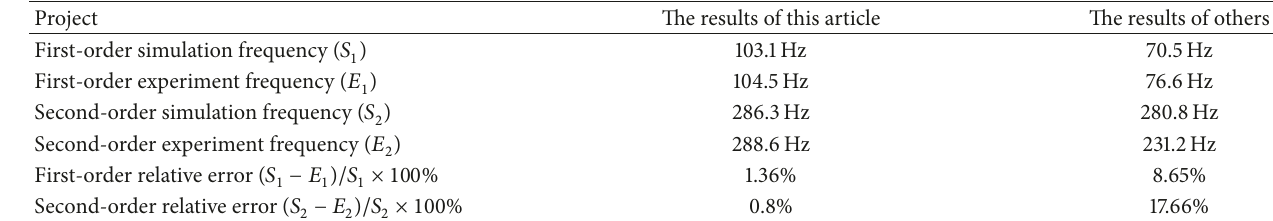
Table 1: The results